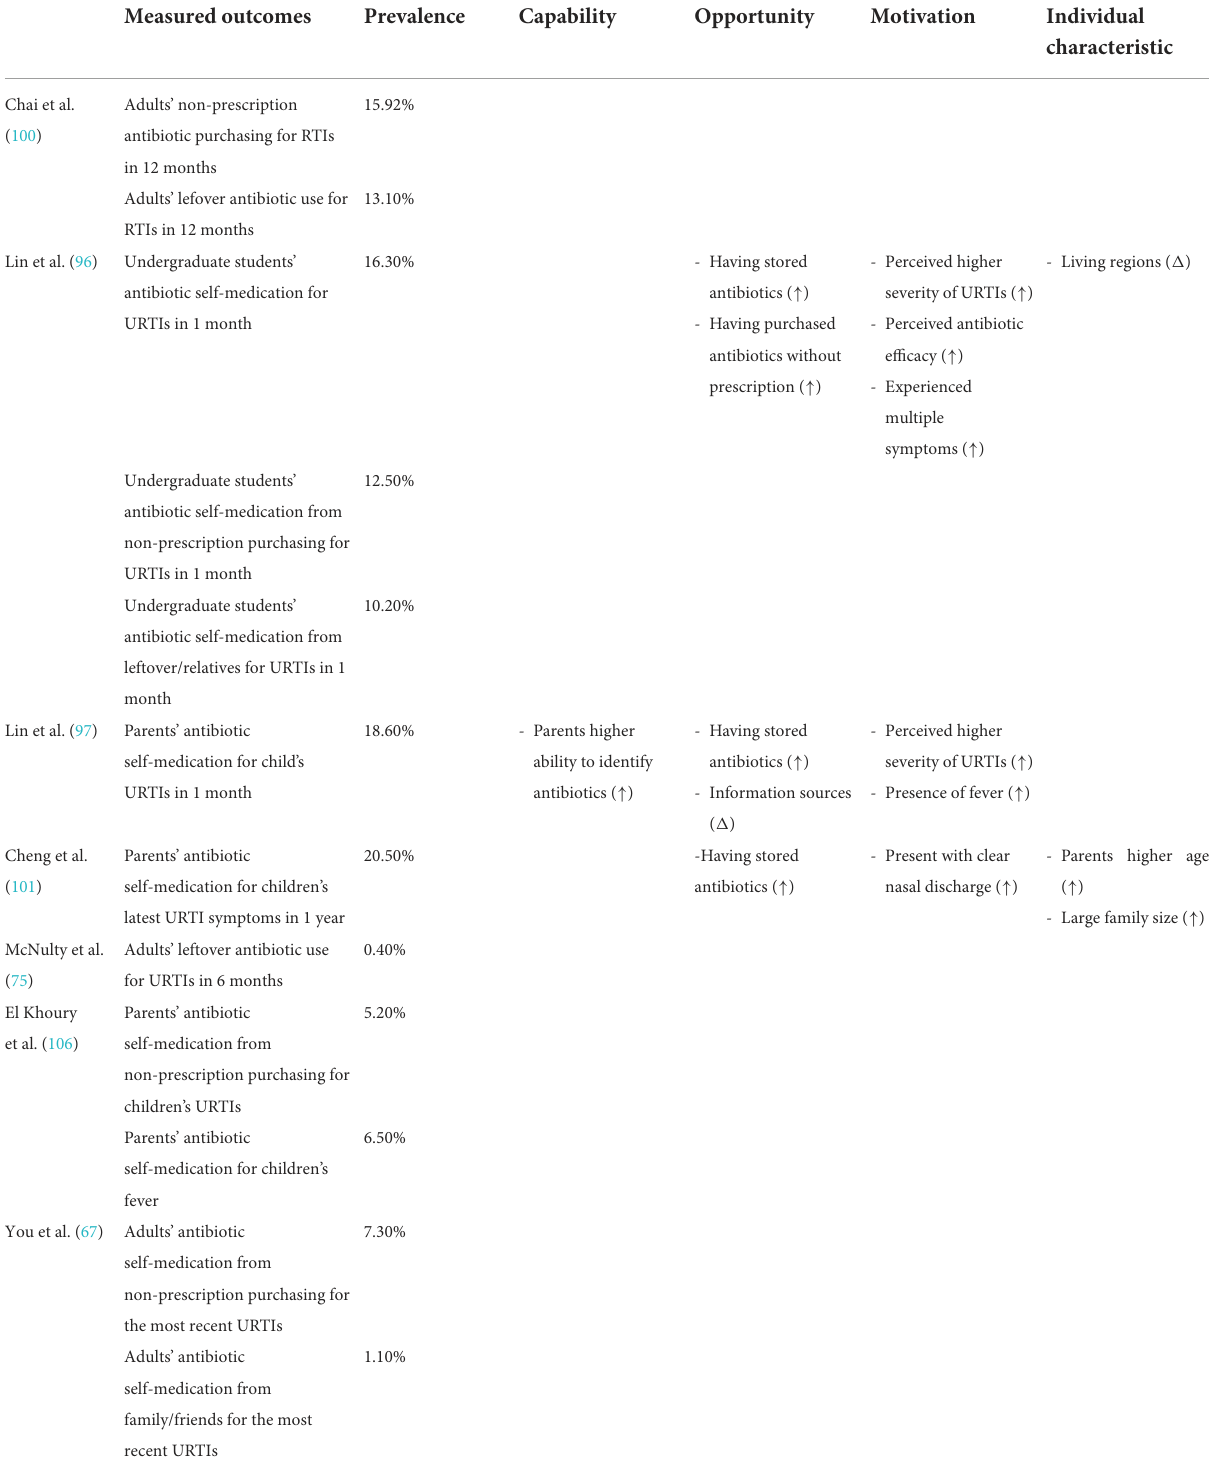
TABLE 4 The public’s antibiotic self-medication behaviors for URTIs and its influencing factors. Study Behaviors Influencing factors Measured outcomes Prevalence Capability Opportunity Motivation Individual